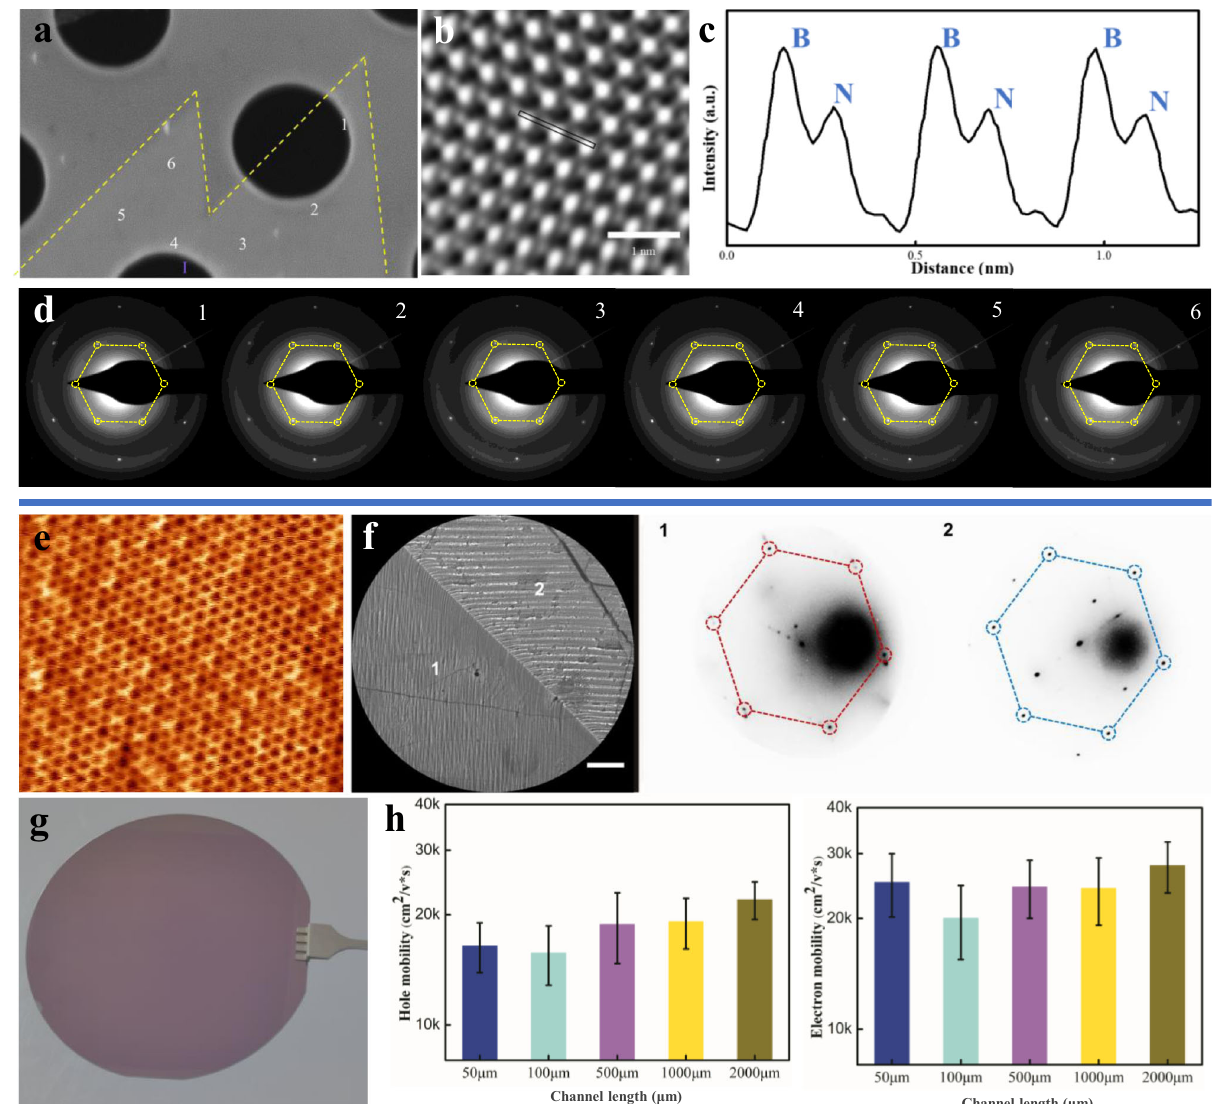
Fig. 4 Characterization of single-crystal hBN and graphene fi lms. a SEM image of two aligned hBN domains merging together; samples were then transferred onto a TEM copper mesh. b The corresponding STEM-ADF image of the merging area around zone I. c The intensity pro fi le measured at the marked position in I. d SAED measurements of the different positions around the merging area. e STM image of the grown single-crystal graphene fi lm. f , LEEM and selected-area μ LEED measurements of the single-crystal graphene grown on a twinned Cu foil (scale bar 3 μ m). g Single crystal graphene fi lm transferred to 4-inch SiO 2 /Si wafer. h Carrier mobility of holes and electrons from the single-crystal graphene-based FET test with different channel sizes (channel width 10 μ m, length 50 – 2000 μ m. The error bar is the standard deviation of raw strain on graphene. Along the direction perpendicular to the step edge, the distance between parallel step edges was maintained at a constant value of ~20Å. In the out of plane direction, the vacuum space between neighboring images was kept at least 12Å to avoid periodic imaging interactions. A force on each atom of less than 0.01eV/Å with an energy convergence of 10 − 4 eV, was used as the criterion for structural relaxation. Computational details are discussed in the supplementary information.